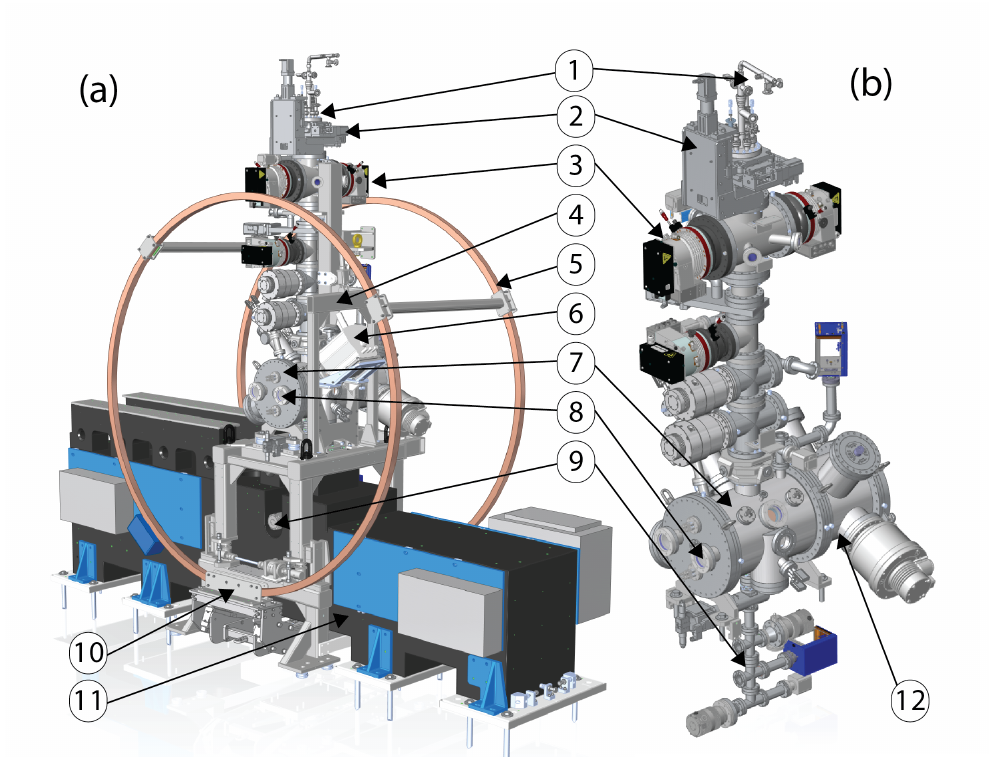
Figure 2. Overview of the DREAM instrument, shown as endstation mounted on the support granite ( a ), and the chamber assembly without support infrastructure ( b ). Indicated are the CW supersonic jet (1), the three-axis jet manipulator (2), the first skimmer stage pumping (3), the holding frame for the skimmer section, which can be moved in tip and tilt (4), the Helmholtz coil pair (5), the long-range microscope (6), the main chamber (7), the close optical laser in-coupling next to the out-coupling (8), the two-stage catcher section with RGA (9), the three-axis coil mover (10), the support granite (11), and the extension chamber (12). Figure and caption adapted from